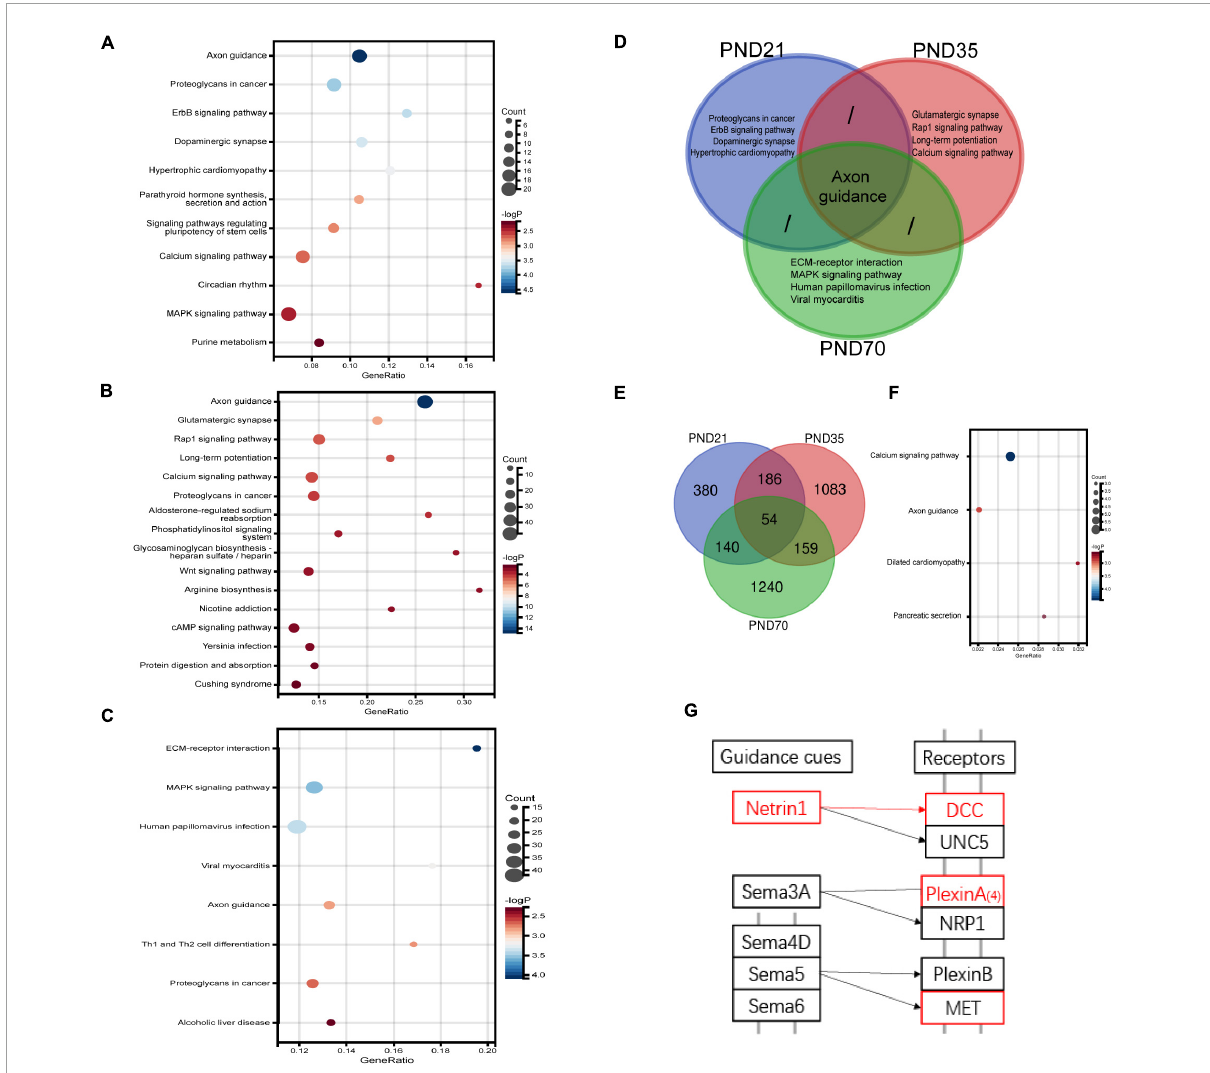
FIGURE4 RNA-seq results of the hippocampus in MS and NC rats of three different age periods ( n = 4 per group). (A–C) The differentially expressed genes (DEGs) on PND21 (A) , PND35 (B) , and PND70 (C) were significantly enriched in various KEGG signaling pathways. The top-ranked pathways were visualized with bubble plots. (D) Venn diagram of enriched pathways showed that axon guidance pathway was the only shared enriched pathway which ranked among top five of all age periods. (E) Venn diagram of DEGs in the hippocampus showed that 54 DEGs were shared in different age periods. (F) A total of 54 shared DEGs were significantly enriched in various pathways, including the axon guidance pathway. (G) A simplified schematic of the axon guidance pathway. Netrin-1, its specific receptor deleted in colorectal cancer (DCC), as well as other two molecules marked in red were upregulated among MS rats of three periods. Netrin-1 and DCC were specific ligands or receptors for each